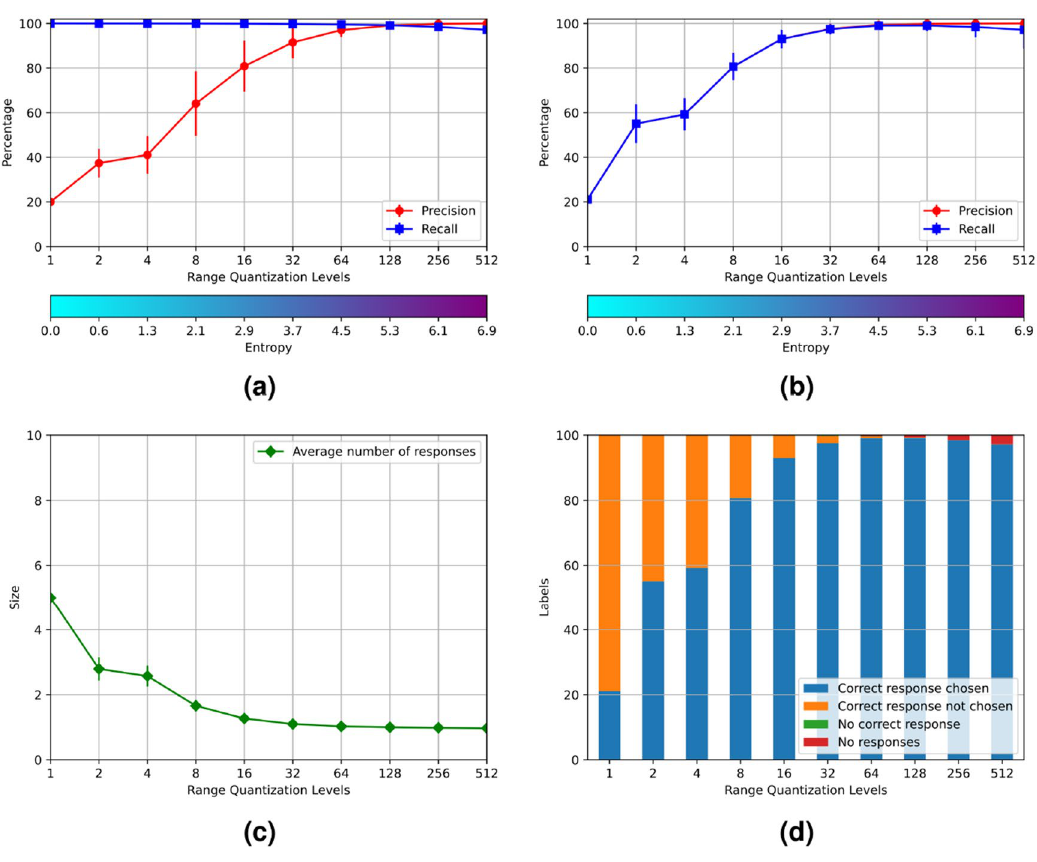
Figure 4. Results of experiment